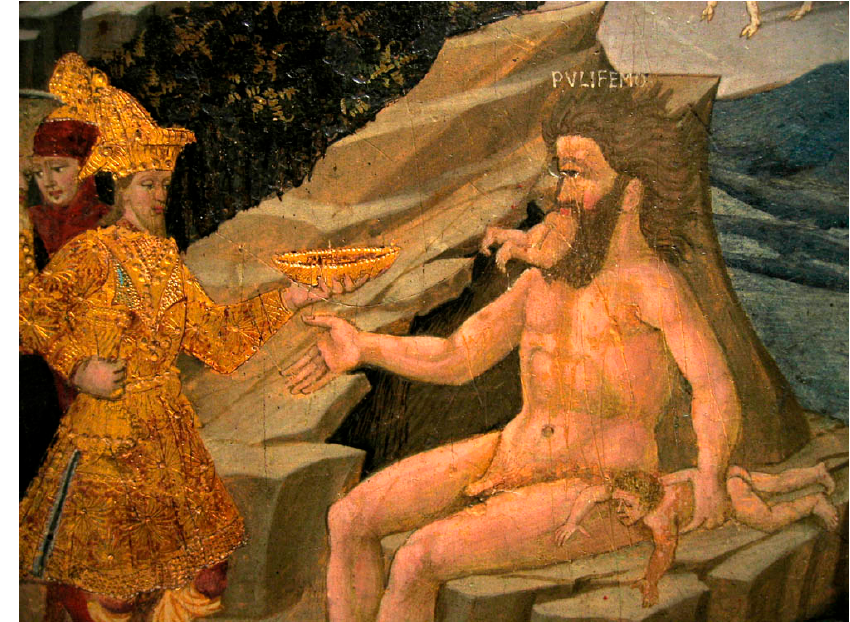
Figure 5. Apollonio di Giovanni, The Adventures of Odysseus , detail Figure 2.